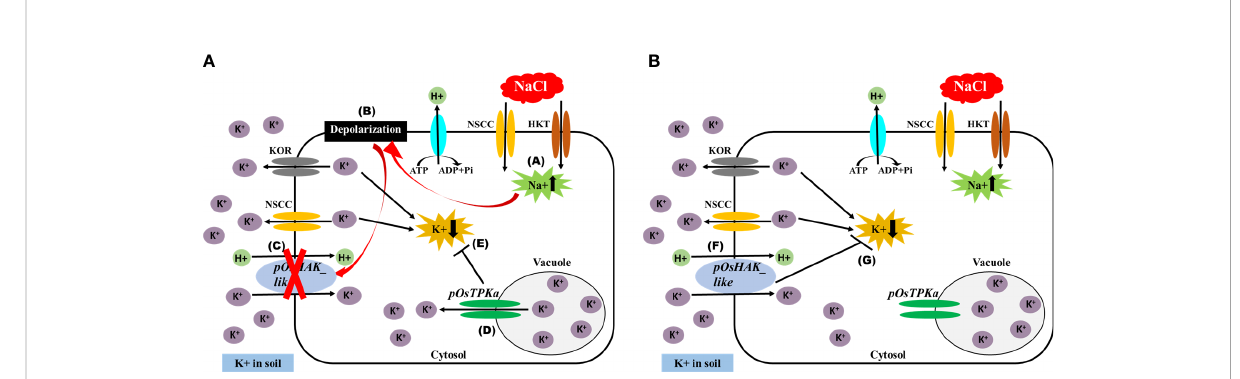
FIGURE 3 Schematic diagram of the proposed mechanism of maintaining K+/Na+ ratio in cytoplasm by coordinated function of OsTPKa and OsHAK_like. (A) Initially under salt stress condition, (A) there is in fl ux of Na+ in cell, (B) which ultimately leads to membrane depolarization, (C) Depolarized membrane inhibits the function of HAK transporter, (D) Vacuolar K+ releases in cytoplasm by TPKa channel, (E) it helps to inhibit the decrease of K+ in cytoplasm. (B) at a later stage of salt stress when there is no depolarization of membrane, (F) HAK participates in uptaking K+ from soil and thus (G) helps to maintain K+ concentration in